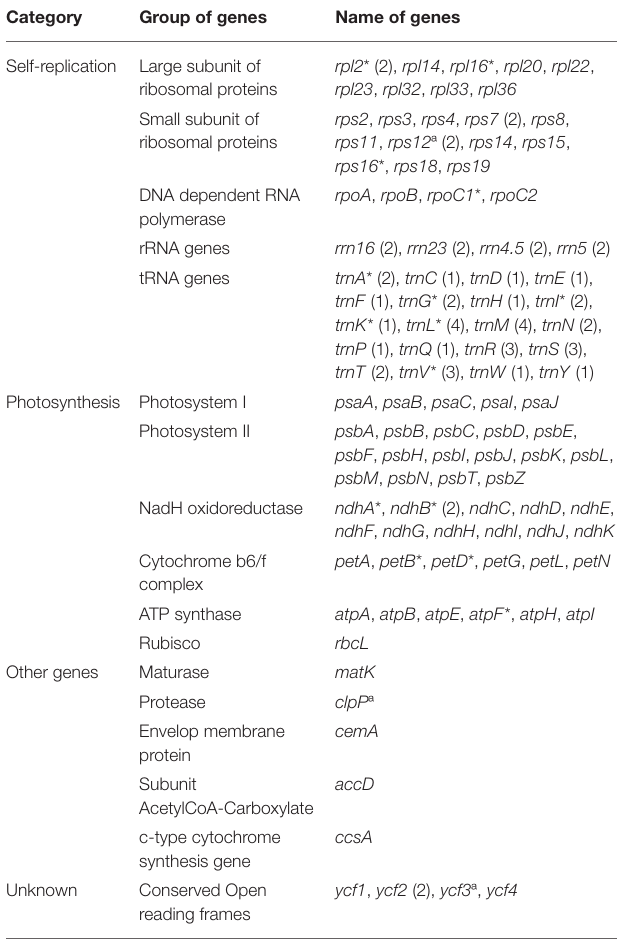
TABLE 2 | Genes in the 24 chloroplast genomes of Nicotiana species. Category Group of genes Name of genes Self-replication Large subunit of ribosomal proteins